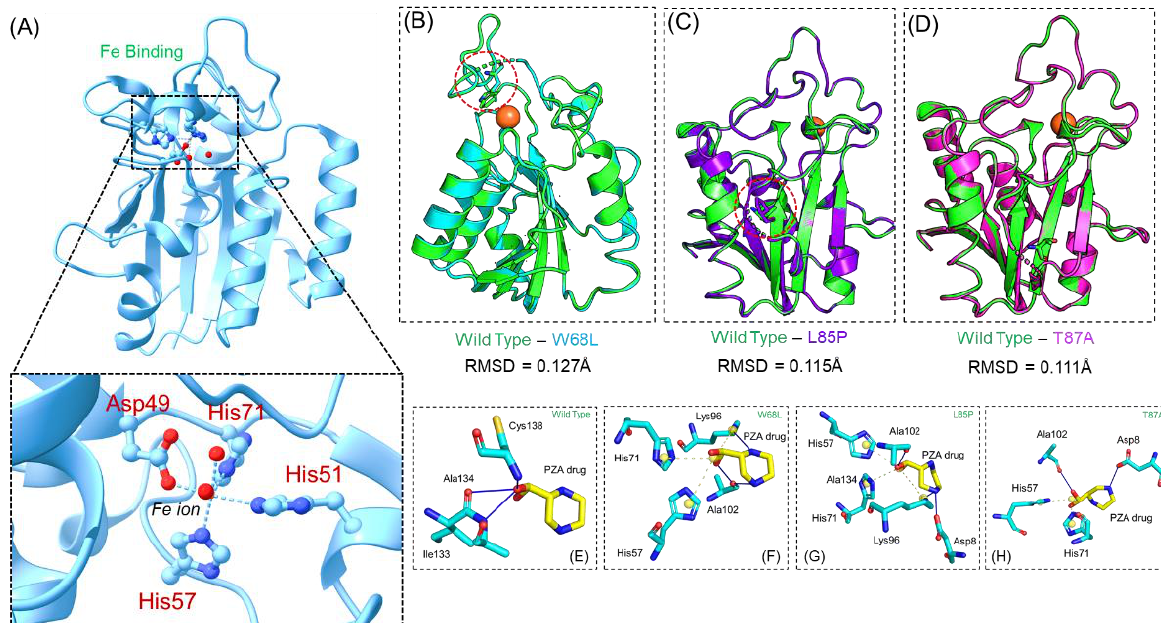
Figure 1. Three-dimensional structure and binding of PZA to the wildtype and W68L, L85P, and T87A mutants. ( A ) The wild type structure of PZase with Fe 2+ ion. ( B – D ) The superimposed structures of the wildtype and three mutants. It also shows the mutations as sticks. ( E ) The binding of the wildtype PZase and PZA, while ( F – H ) represent the binding of PZA to W68L, L85P, and T87A mutants. (RMSD = root mean square deviation).